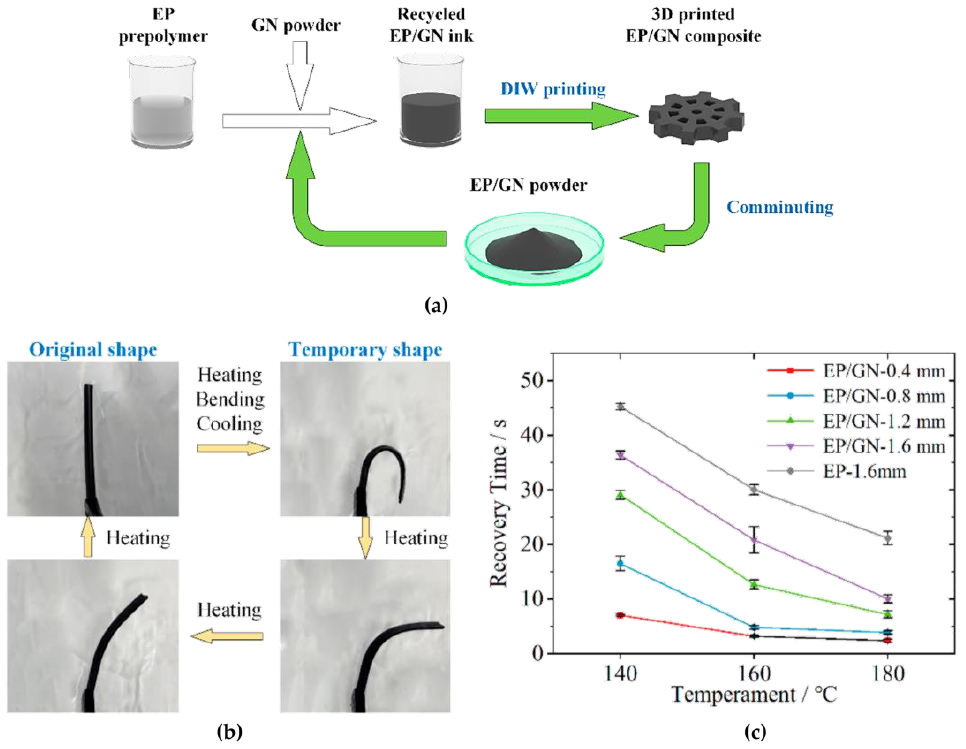
Figure 24. ( a ) Recycling of EP/GNP materials for DIW 3DP, ( b ) shape recovery process of a 3D- printed specimen, ( c ) shape recovery time of samples with different thicknesses at different temper- atures [191]. Copyright © 2022,